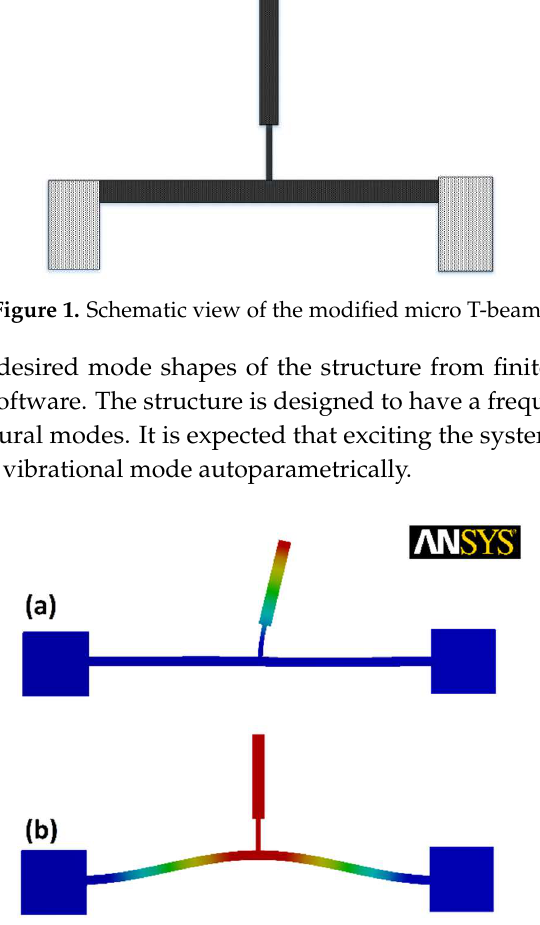
Figure 2. In-plane mode shapes of the micro T-beam structure obtained from ANSYS ® FEM simulation: ( a ) the first mode ( b ) the second mode.